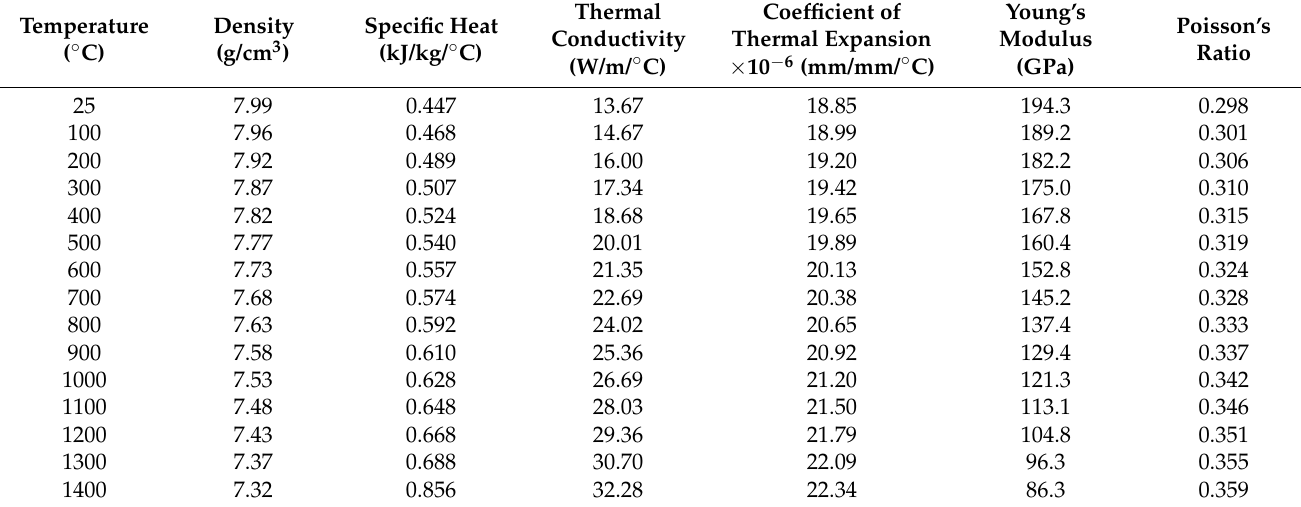
Table 10. Thermo-physical properties data of 316L.